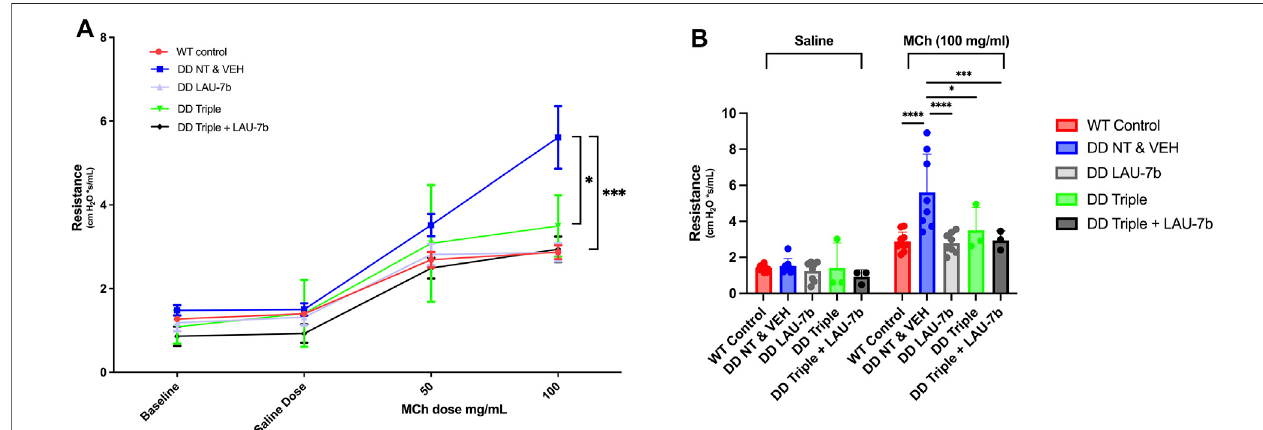
FIGURE1| Airwayfunctionissigni fi cantlyimprovedinF508del/F508del(DD)miceupontreatmentwithTripletherapy,andfurtherimprovedbyadditionofLAU-7b, in response to MCh challenge. Treatment groups include Wild-type (WT) control (Non-treated & Vehicle, NT and VEH) (Red), DD NT and VEH (Blue), DD LAU-7b (Grey), DD Triple therapy (Green) and DD Triple + LAU-7b (Black). (A) Comparisons shown between DD NT and VEH and DD Triple ( p = 0.0118) and between DD NT and VEH and DD Triple + LAU-7b ( p = 0.0003). (B) Detailed analysis of the saline and 100 mg/ml MCh dose among the treatment groups. n = 3 – 12 mice for each group. Two-way ANOVA with Sidak correction where * p < 0.05, ** p < 0.005, *** p < 0.0005 and **** p <